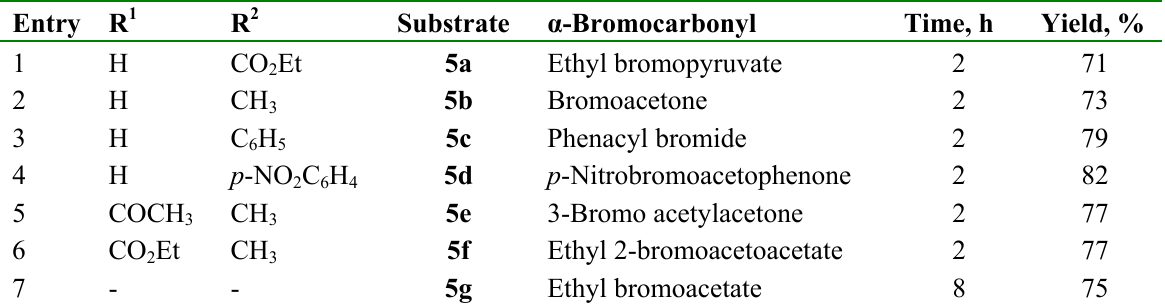
Table 1. Results of reaction 4a and α -bromocarbonyl compounds in DMF at room temperature.